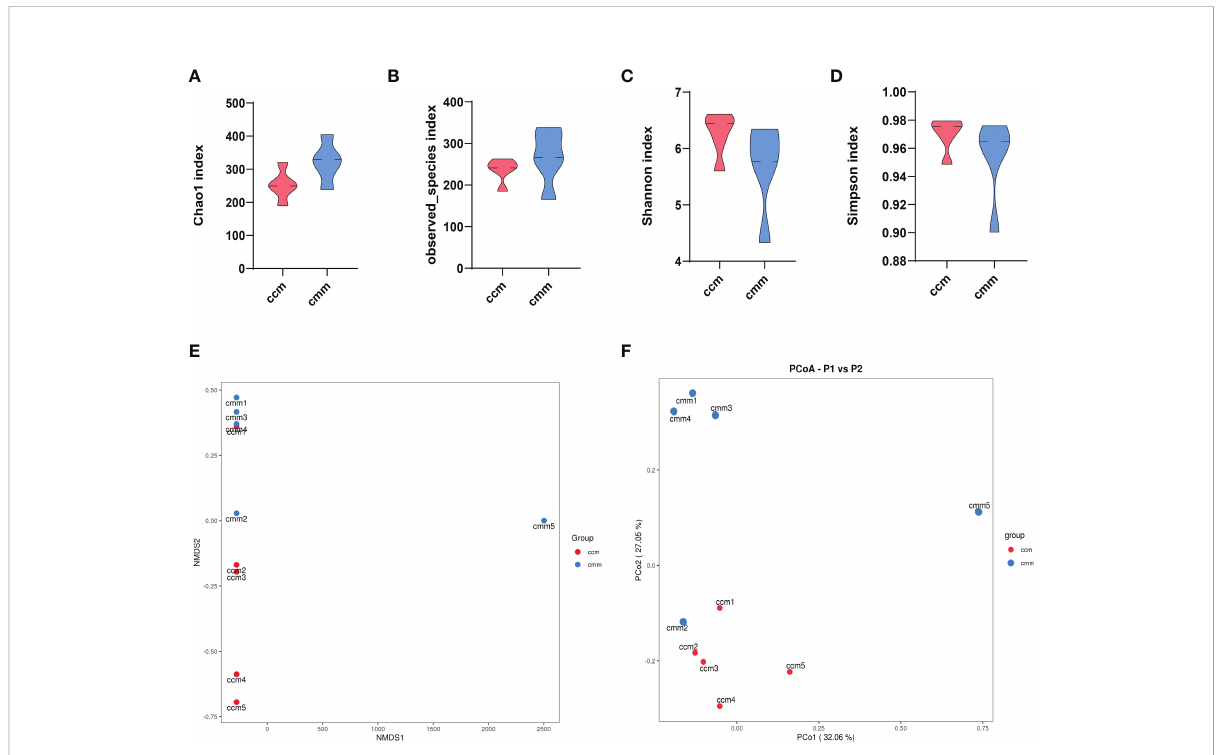
FIGURE 3 The diversity index for all three groups of animals. (A – D) Chao1 index, Observed_species index, Shannon index, Simpson index. (E) NMDS analysis. (F) PCoA analysis. ccm group, control group; cmm group, model group ( n =